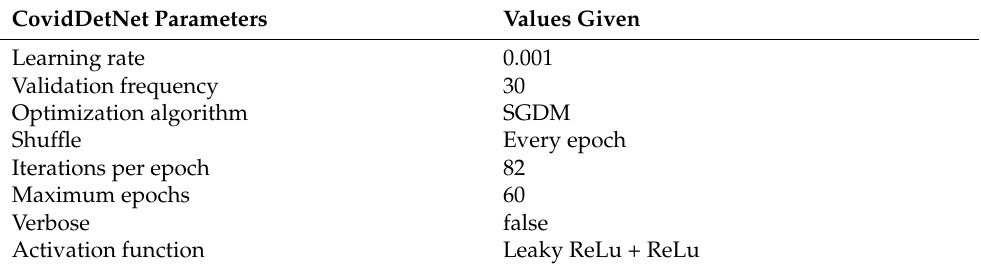
Table 2. Selected parameters for CovidDetNet